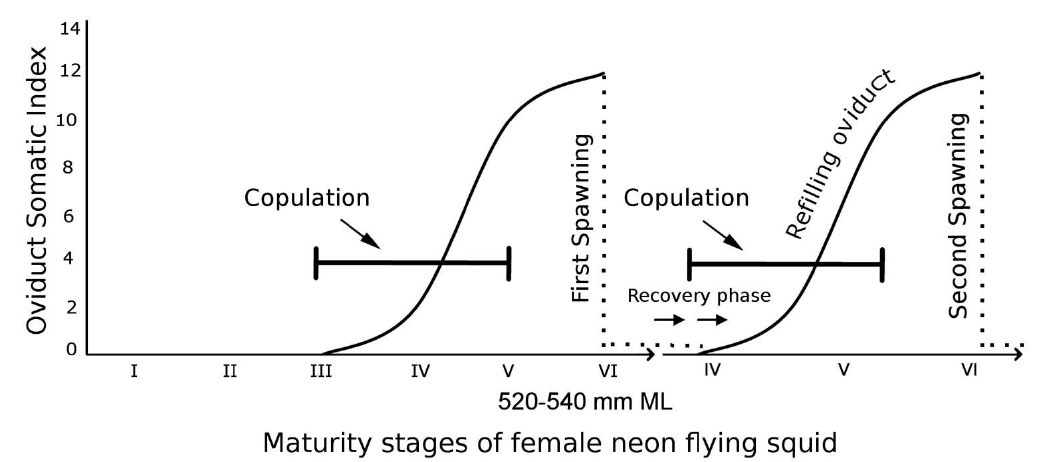
Fig. 7. – Schematic of the spawning events of Ommastrephes bartramii . We assumed that the first spawning event occurs at ~520-540 mm mantle length (ML). Subsequently, the female feeds, undergoes somatic growth, and refills the oviduct before the second spawning event